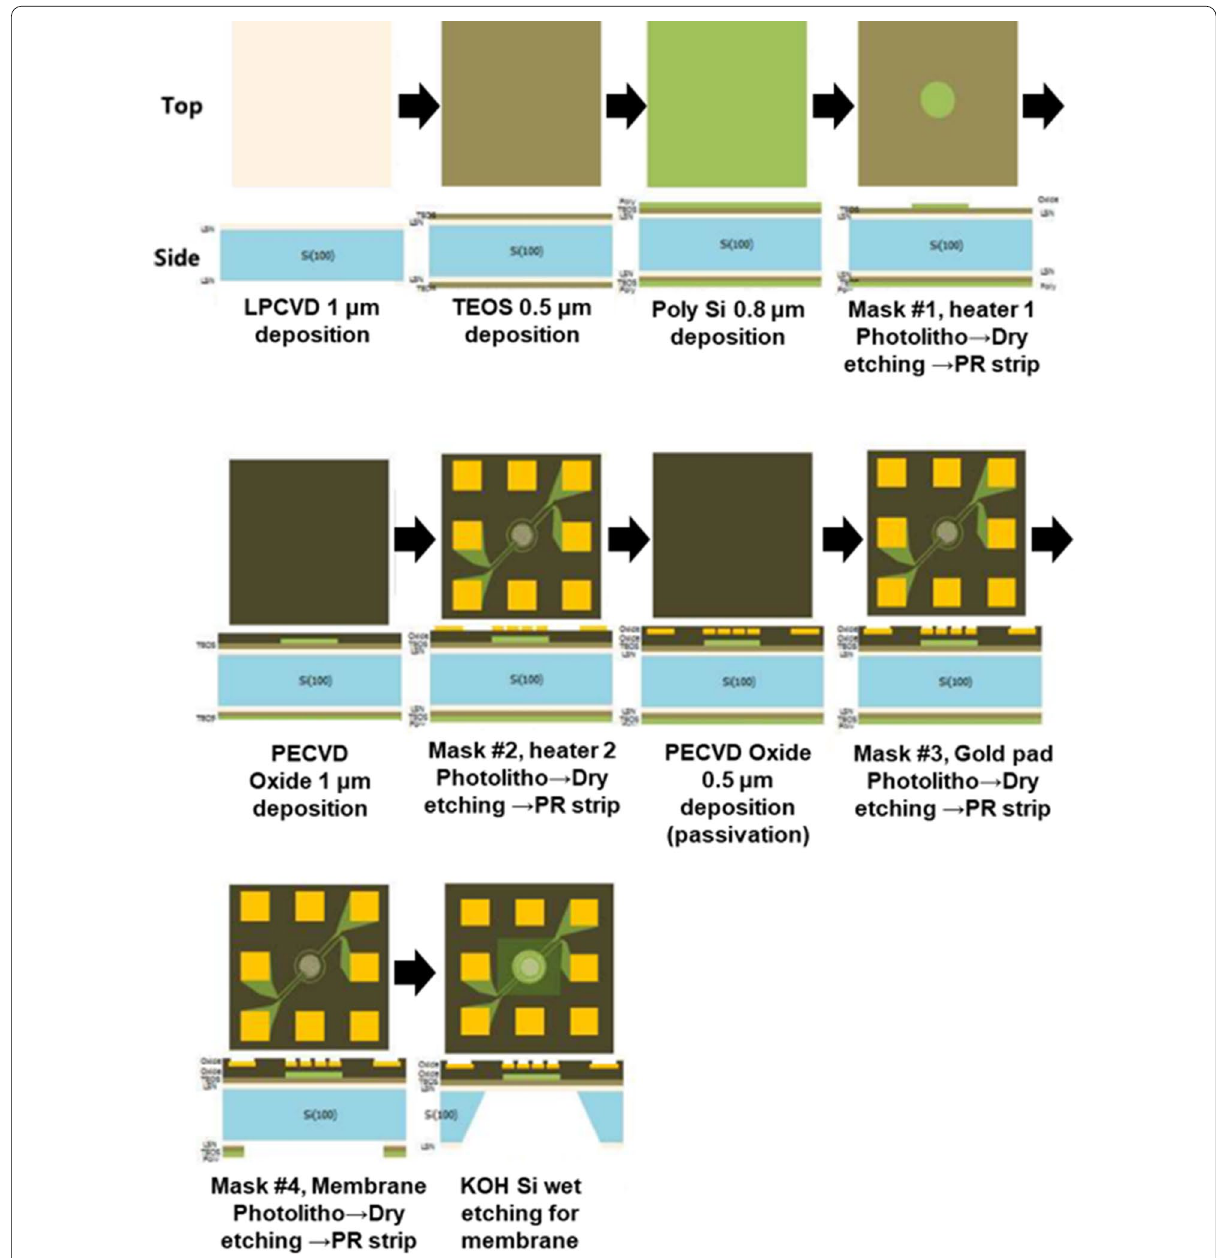
Fig. 1 Schematic process of MEMS microheater